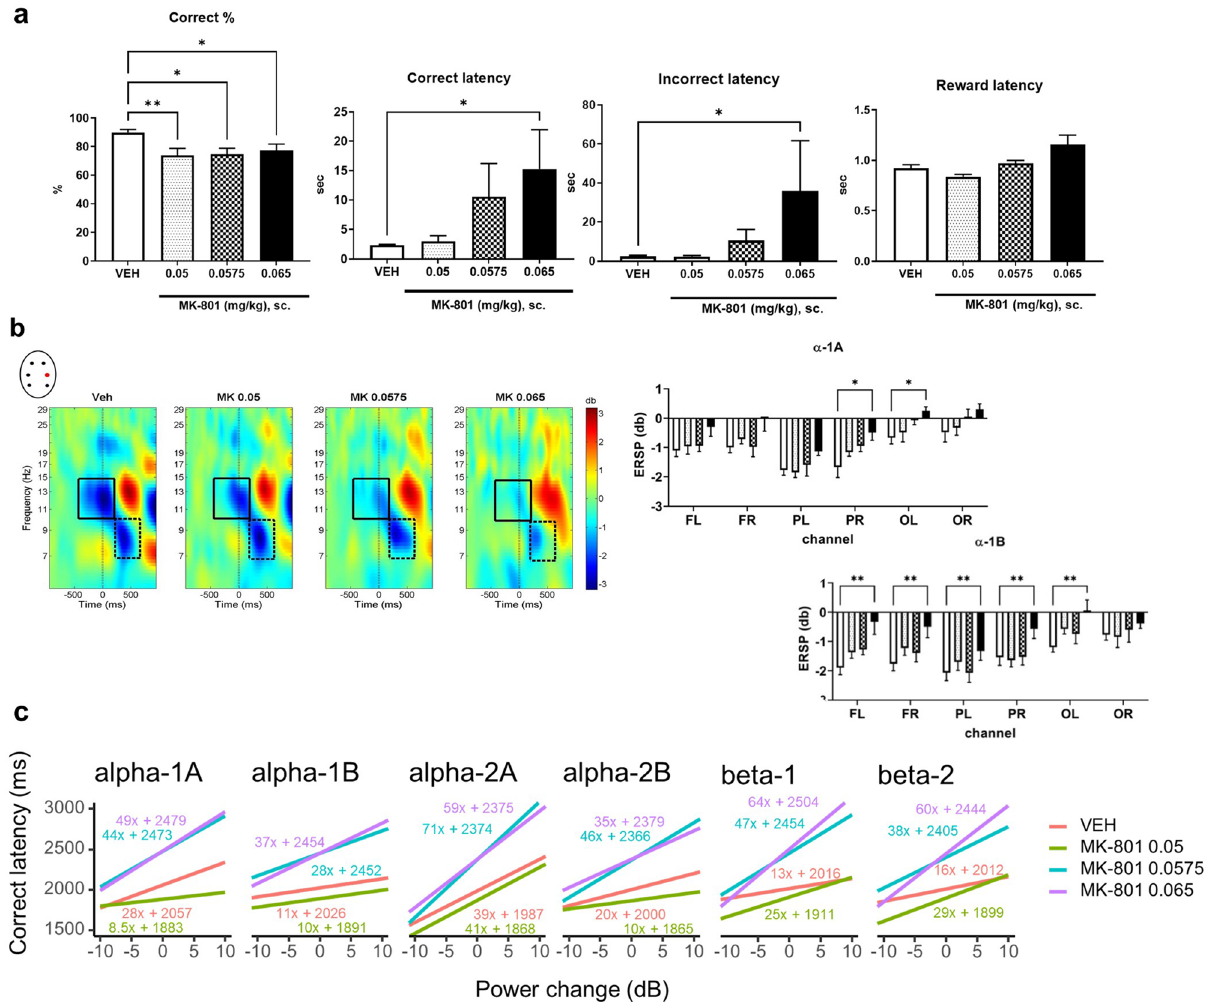
Figure 4. Experiment 2: Effects of MK-801. ( a ) Behaviour. MK-801 decreased the percent of correct choices and elongated the response latency times mainly at the highest dose without affecting reward collection latency. Data represent mean ± SEM values. * p < 0.05 and ** p < 0.01 show significant multiple comparisons test effects of groups treated with different doses of MK-801 compared to the vehicle group. ( b ) ERSP power. ERSP plots represent the power change from baseline (decibel, db) in each group separately at the PR electrode; black rectangles highlight the alpha-1A (10–15 Hz, − 450 – + 200). and alpha-1B (7–10 Hz, + 200–600) cycles. Graphs show the effect of MK-801 in the alpha-1A and alpha-1B cycles at each electrode, separately. Data represent mean ± SEM values, asterisks indicate significant differences compared to the control: *p < 0.05 and **p < 0.01. Note that both alpha-1A and alpha-1B ERD are very robust in vehicle condition, which gradually decline with increasing scopolamine dose. Abbreviations: FL frontal left, FR frontal right, PL parietal left, PR parietal right, OL occipital left, OR occipital right electrodes. ERSP maps were created by the EEGLab toolbox of MatLab. ( c ) Single-trial ERSP and reaction time relationship. Plots show the dependence of correct latency (reaction time) on ERSP power in each time–frequency domain after vehicle or MK-801 treatment based on the linear mixed effect analysis (LME). The regression lines are focal predictor effects from a fitted LME model with treatment and channel as fixed effects and subject as random effect. Slopes of regression lines show effect size (the predicted change in correct latency for unit ERSP power change), while y-intercept values are used to show how treatment modulates correct latency in